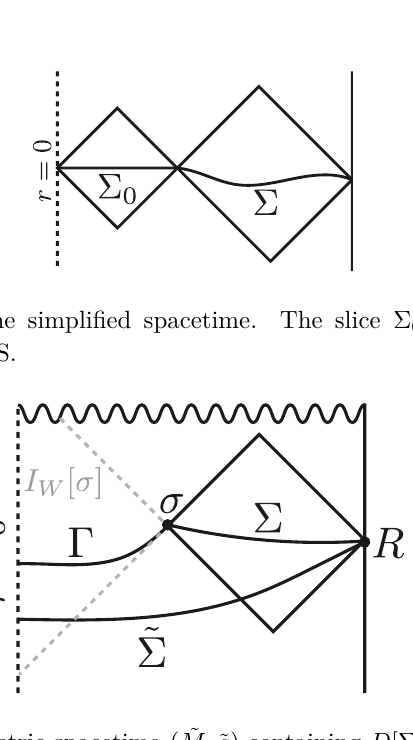
Figure 8 . A spherically symmetric spacetime ( ˜Σ must have volume greater or equal to